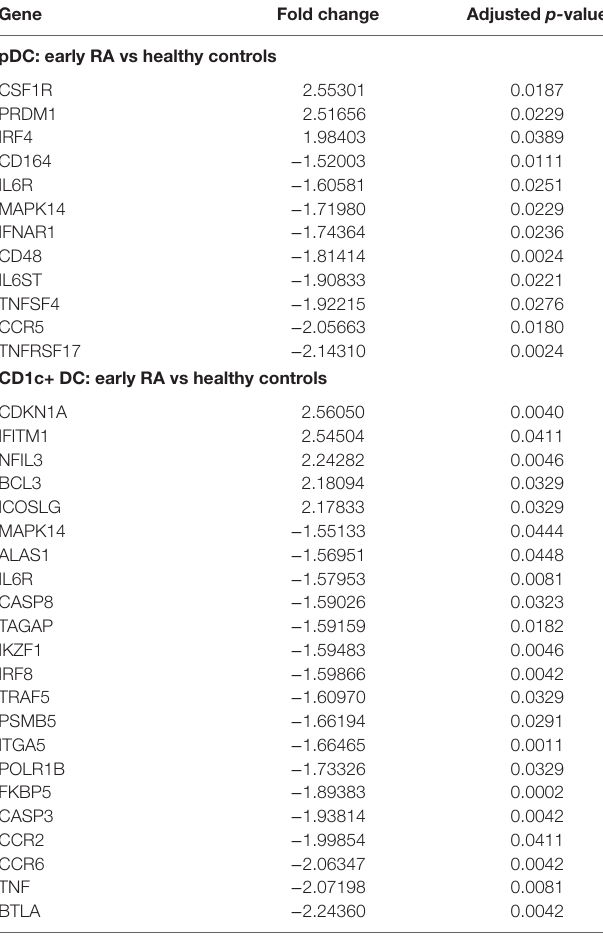
TaBle 2 | Differentially expressed genes between early rheumatoid arthritis (RA) and healthy control DCs. gene Fold change adjusted p-